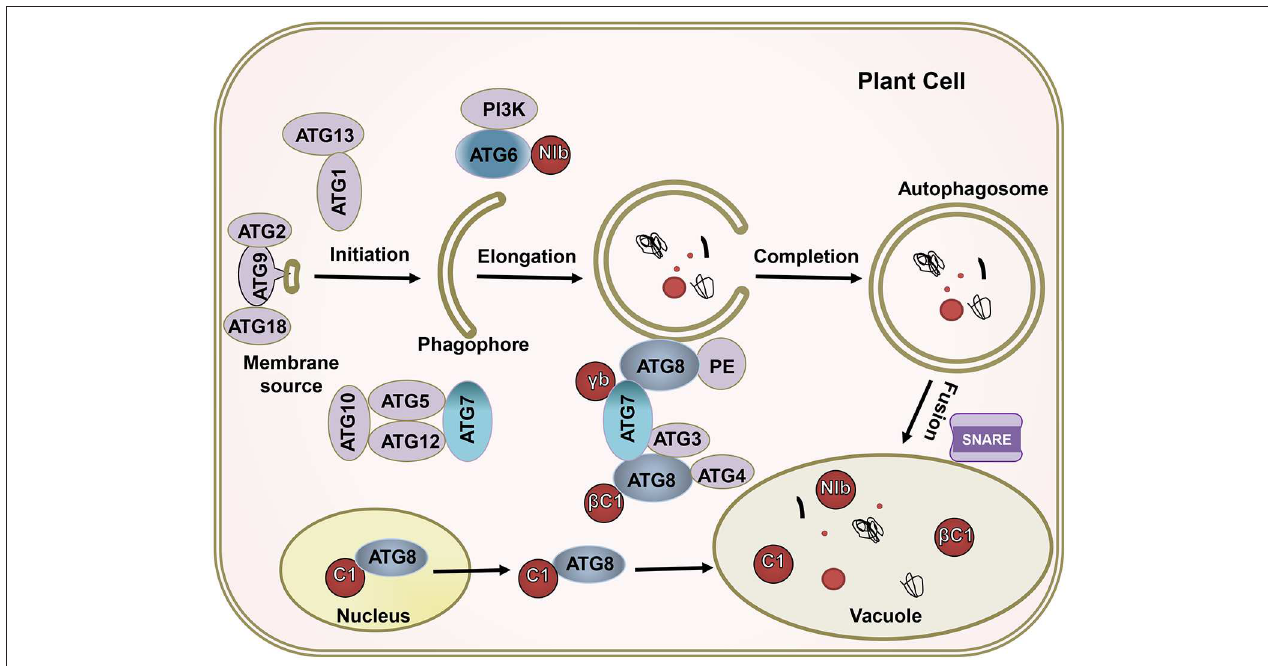
FIGURE 2 | The ATGs target viral proteins for degradation by the autophagy pathway. The autophagy pathway includes four key steps including initiation, elongation, completion, and fusion. Most ATGs drive this process; β C1 of geminivirus, NIb of PVY, γ b of BSMV, and C1 of TLCYnV; these virus effectors (red) interact with crucial autophagy genes, like ATG6, ATG7, and ATG8. The ATGs target viral proteins for their